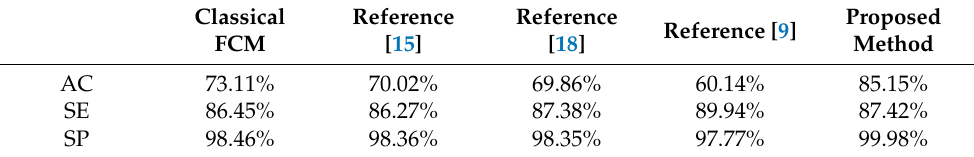
Table 4. Performance comparison of different pupil segmentation algorithms for Dataset I.